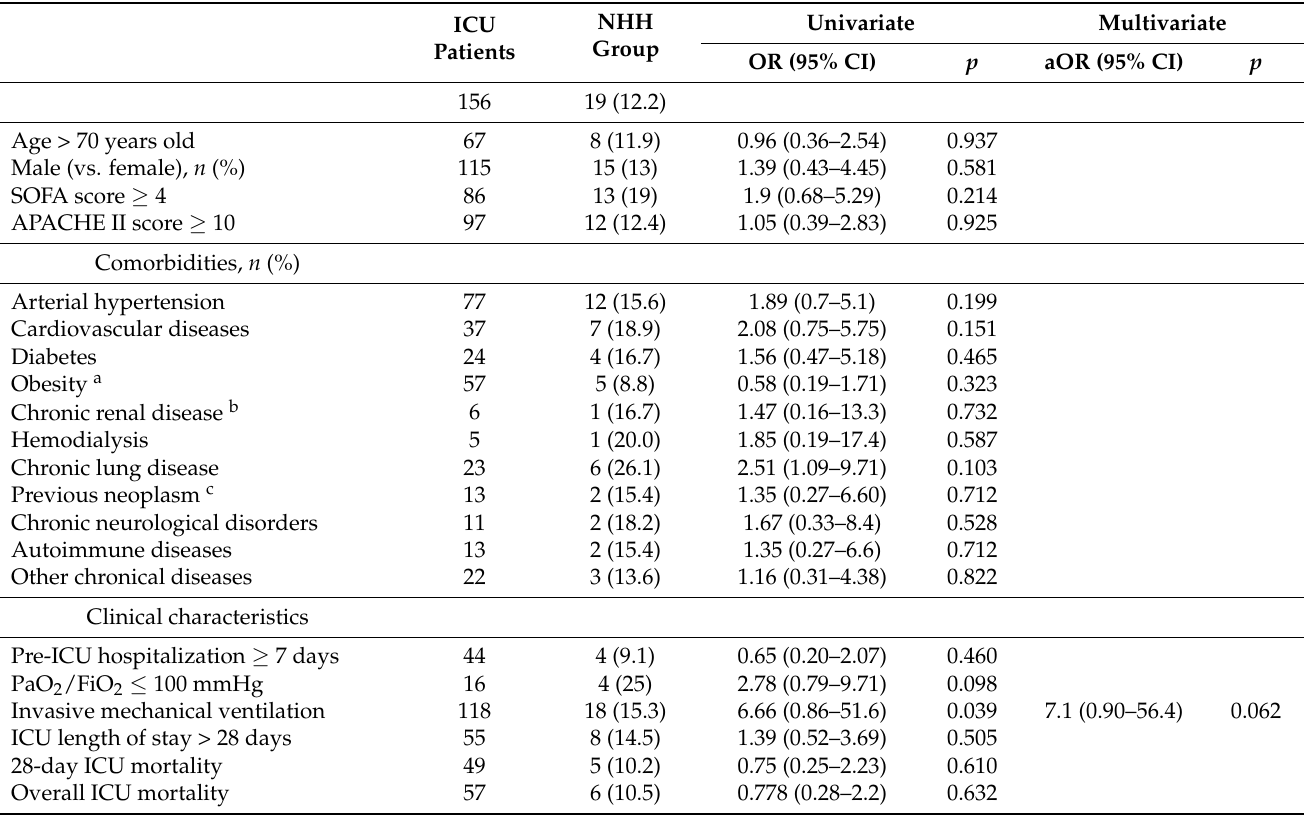
Table 2. Unadjusted and adjusted risk factors for NHH in ICU COVID-19